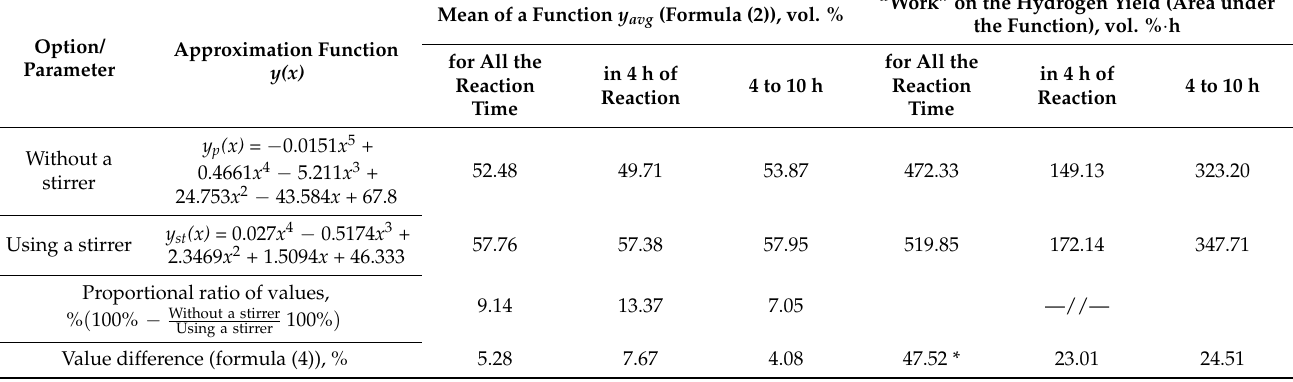
Table 1. Quantitative evaluation of stirrer influence on hydrogen yield in catalytic pyrolysis of non-condensable gases.